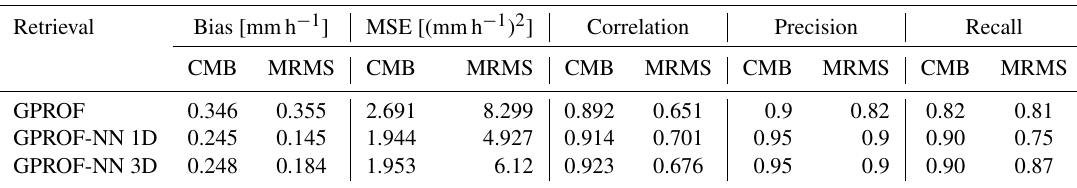
Table 7. Accuracy metrics for surface precipitation retrieved from GMI PMW observations of Hurricane Harvey for the overpass on 25 Au- gust 2017 at 11:50:00UTC. Each metric is calculated with respect to the surface precipitation from the CMB product as well as the surface precipitation from MRMS as